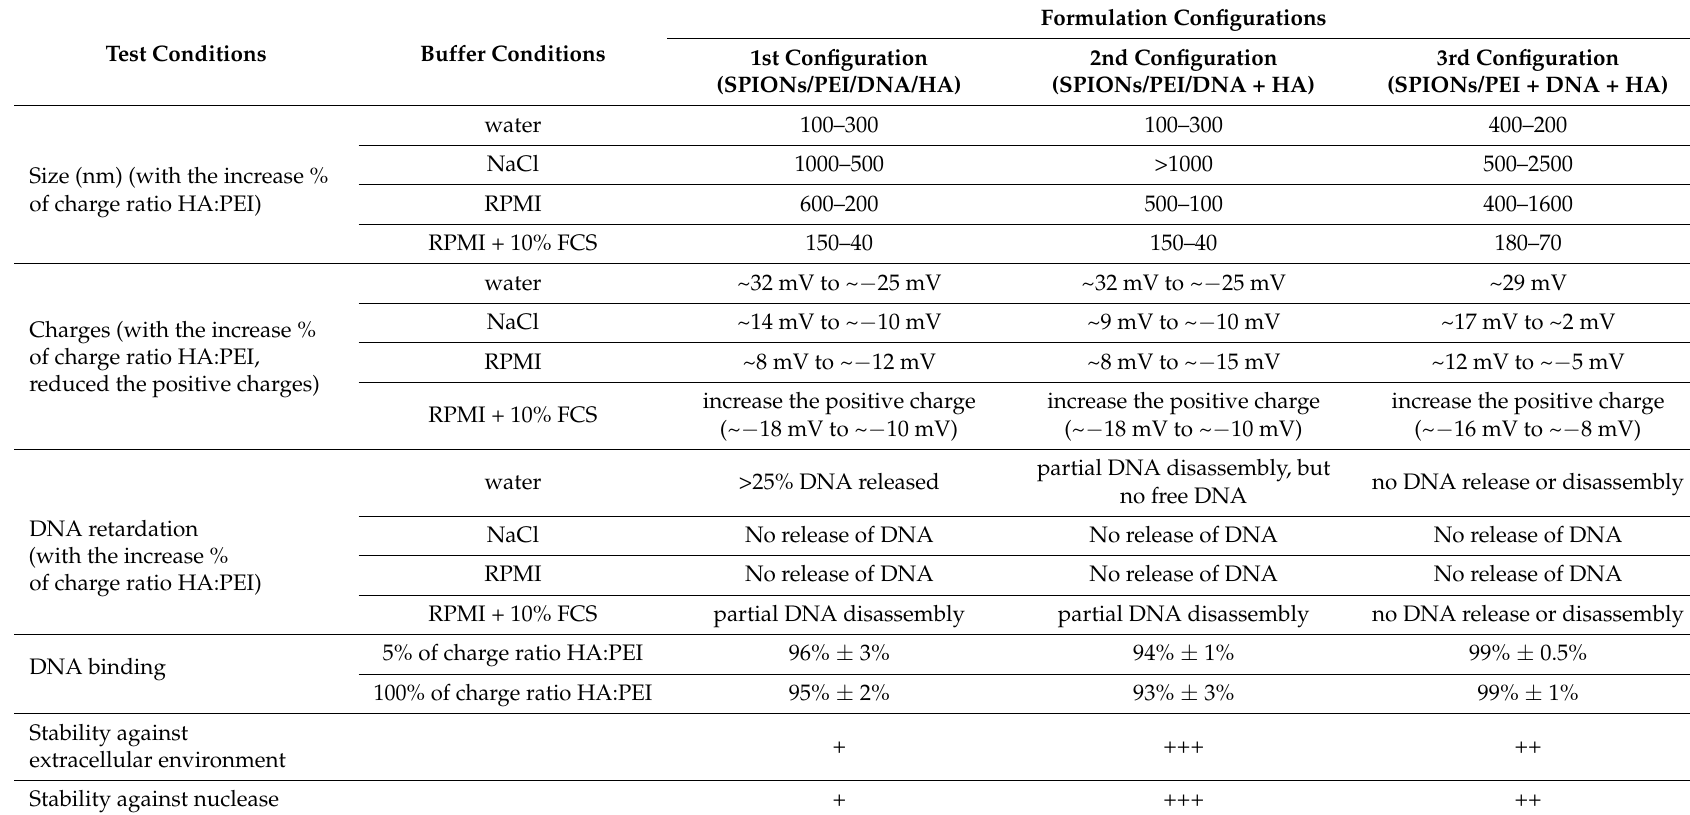
Table 1. Summary of properties of different magnetic gene vector